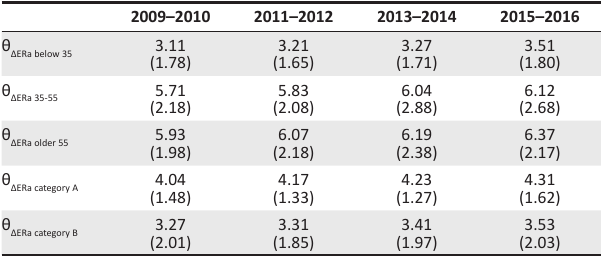
FIGURE 7: Summary of panel data estimations: Ergonomic characteristics.